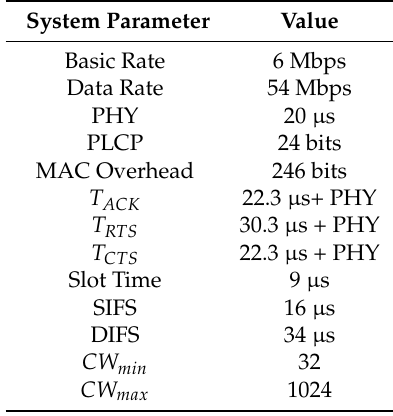
Table 1. IEEE 802.11 System parameters.